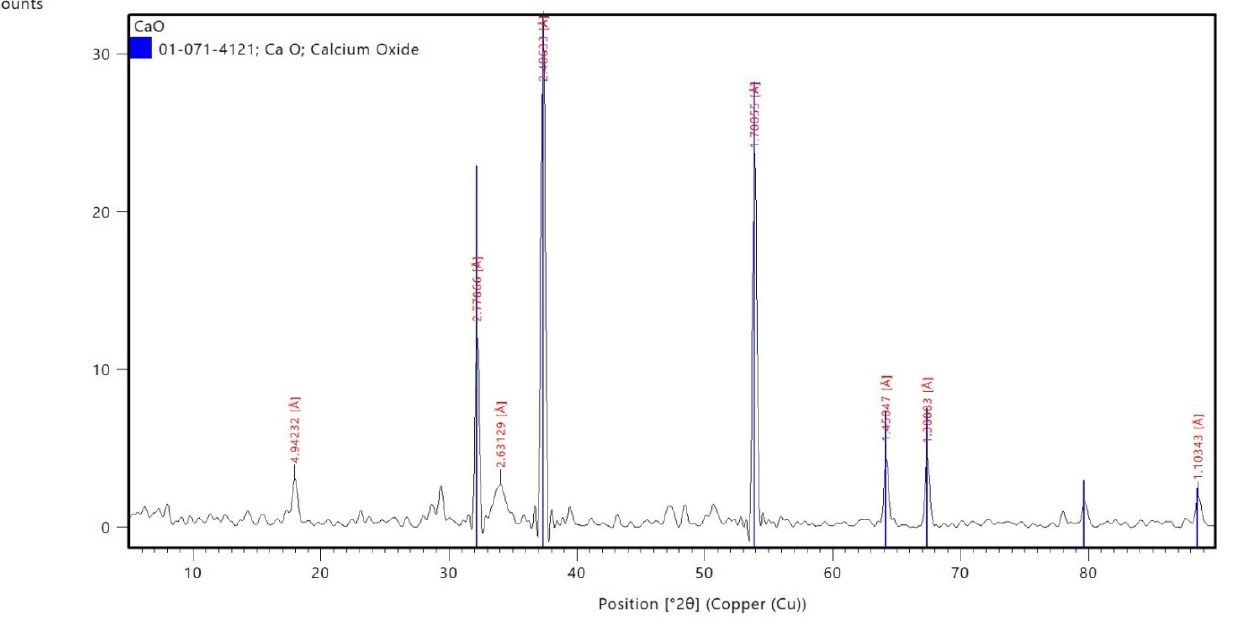
Figure 6. Mineralogical analysis of CaO including the peaks list of CaO and the reference sample.